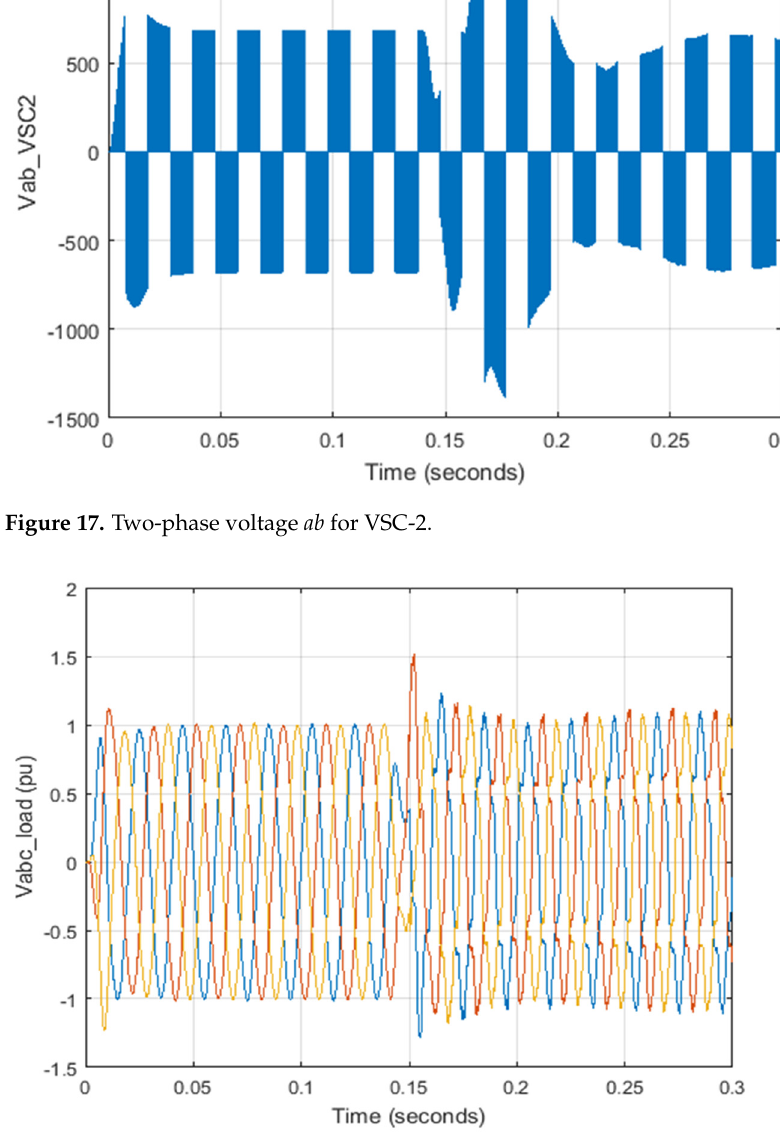
Figure 18. Load voltage.